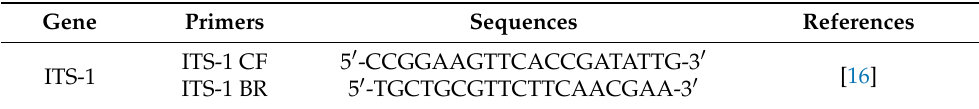
Table 1. Primers used to amplify the ITS-1 gene using DNA extracted from T. evansi . Gene Primers